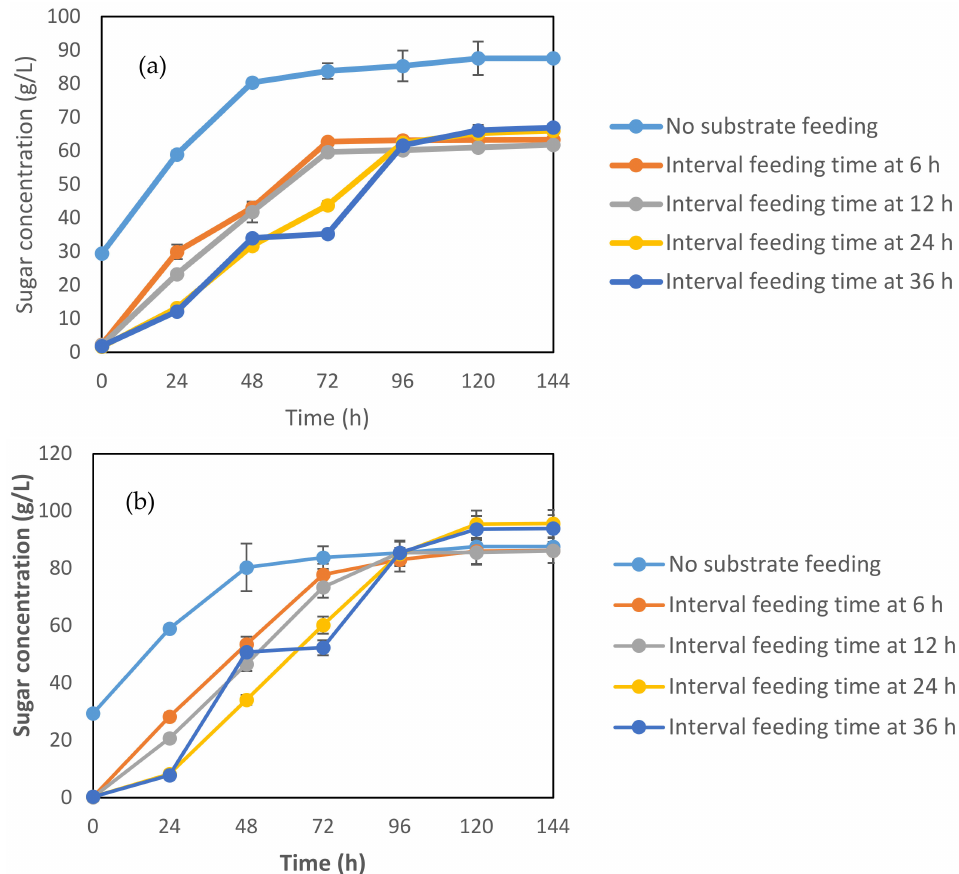
Figure 3. Effect of the feeding interval of the substrate in the saccharification process: ( a ) initially loaded enzymes only; and ( b ) sequentially loaded enzymes according to substrate